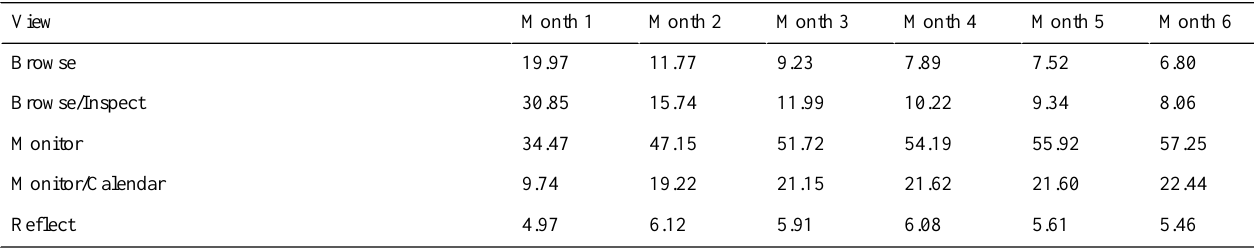
Table 3. Distribution of views visited and changes over months.